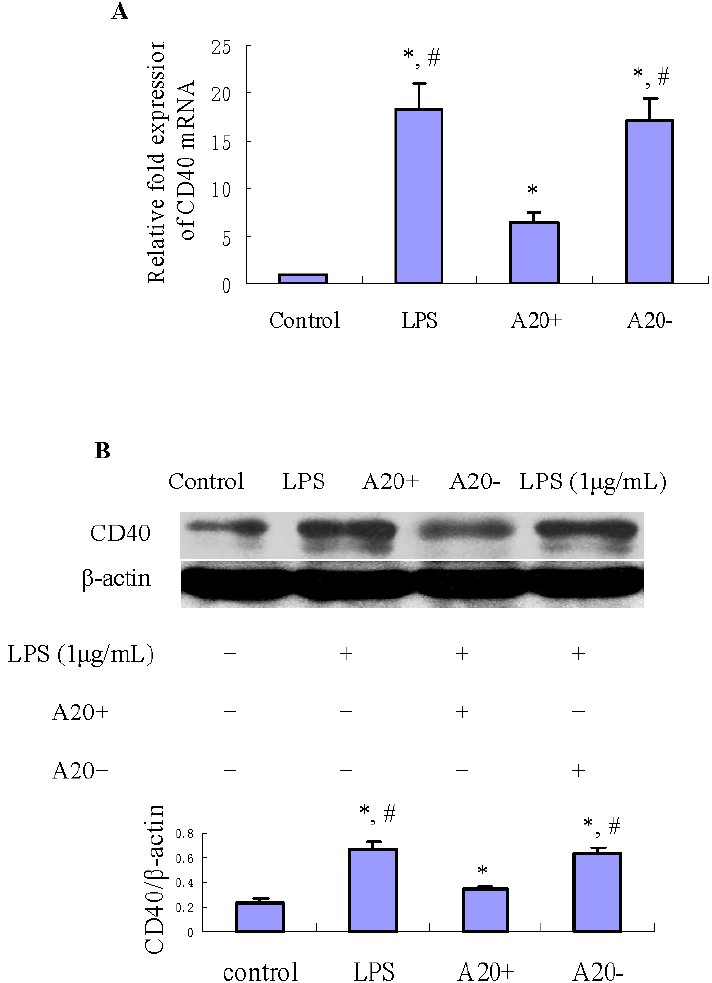
Figure 5. Effects of A20 on LPS-induced CD40 expression in RPMCs. Cells were pre-transfected with pGEM-T easy- A20 or pGEM-T easy for 24 h. Cells incubated with serum-free DMEM/F12 alone were used as the control. Near confluent cells were cultured in serum-free medium for 24 h to arrest and synchronize cell growth and then exposed to LPS (1 μ g/mL) for 24 h. RT-PCR and immunoblot analyses were performed to determine the mRNA and protein expression levels of CD40. The relative expression of CD40 protein was determined by normalization to β -actin. Results were obtained from three independent experiments. ( A ) Bar graph shows the expression of CD40 mRNA. Data are presented as the mean ± SD ( n = 3). * p < 0.05 vs. control; # p < 0.05 vs. A20+; ( B ) Bar graph shows the expression of CD40 protein. Western blots are representative of three independent